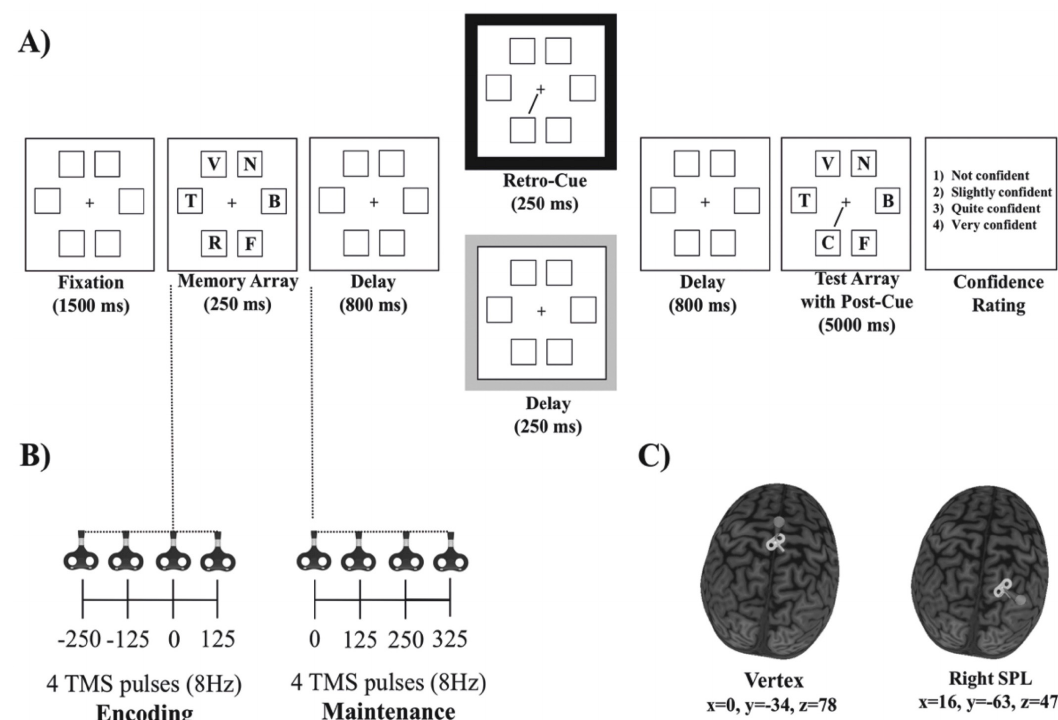
Figure 1. ( A ) Sequence of the events in a given trial. The black and gray boxes represent retro-cue and post-cue trials, respectively. ( B ) Transcranial magnetic stimulation (TMS) protocol: a burst of four TMS pulses at 8 Hz, administered either during the encoding phase or during the maintenance phase. ( C ) TMS sites: vertex (left panel) and right superior parietal lobe (SPL) (right panel).